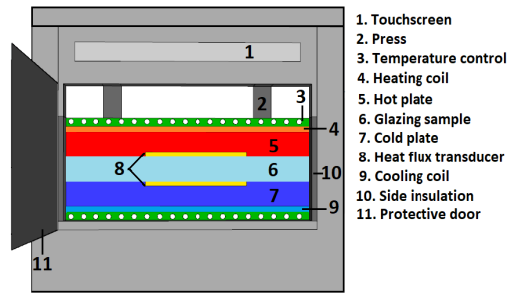
Figure 3. Schematic of a single-specimen heat flow meter apparatus.